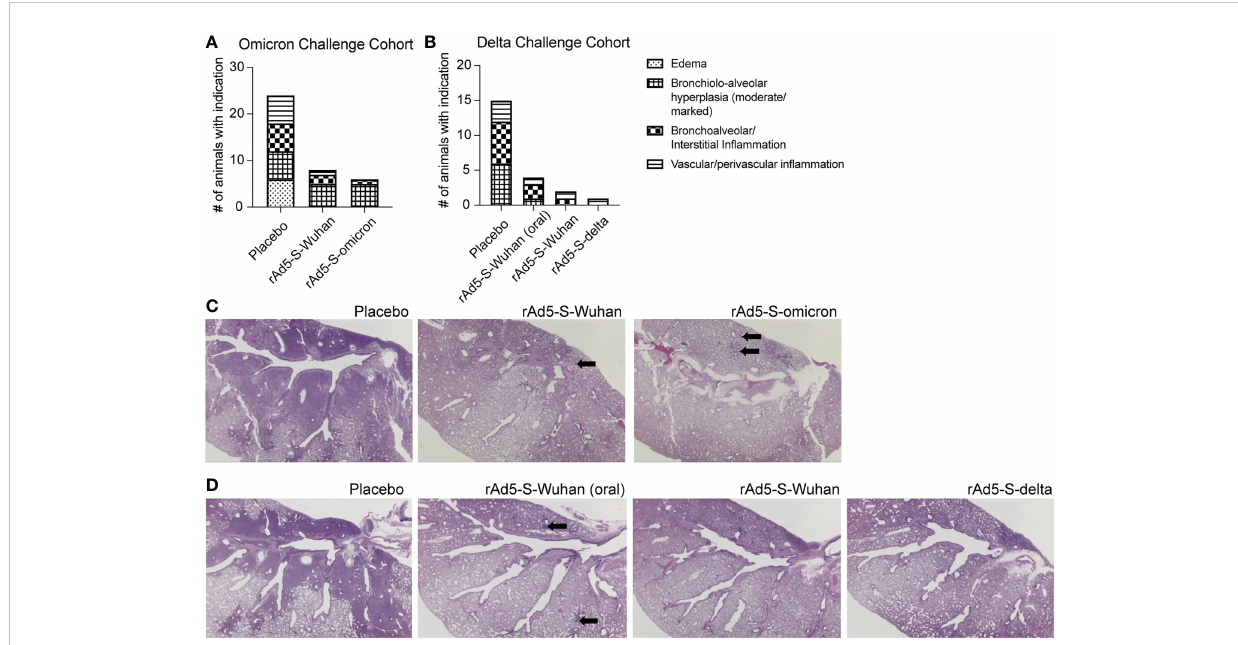
FIGURE 6 Lung pathology from placebo and rAd5-S vaccinated hamsters. (A) Number of animals with minimal/mild edema, moderate/marked bronchiolo- alveolar hyperplasia, minimal-moderate bronchoalveolar/interstitial in fl ammation, or minimal-mild vascular/perivascular in fl ammation from omicron cohort. (B) same as A, but from delta cohort. (C, D) Representative H&E of hamster lungs from the omicron cohort (C) and delta cohort (D) . Arrows indicate areas brochiolo-alveolar